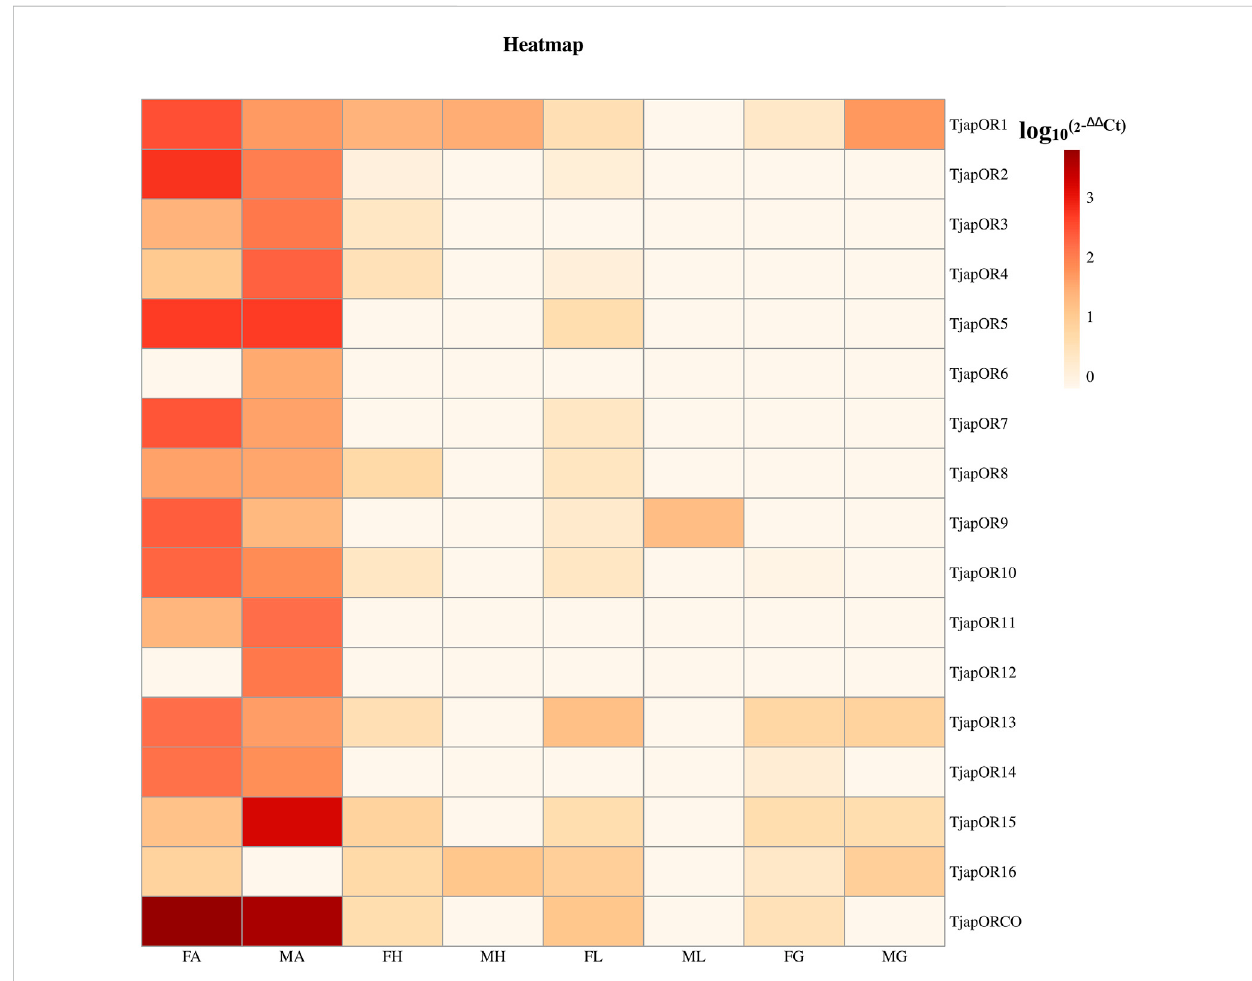
FIGURE 10 Relative expression levels of all TjapORs in different tissues of females and males. FA: female antennae, MA: male antennae, FH: female heads (without antennae), MH: male heads (without antennae), FT: female thoraxes, MT: male thoraxes, FG: female external genitals and MG: male external genitals. Note: the heatplot fi gure was built using the data set of